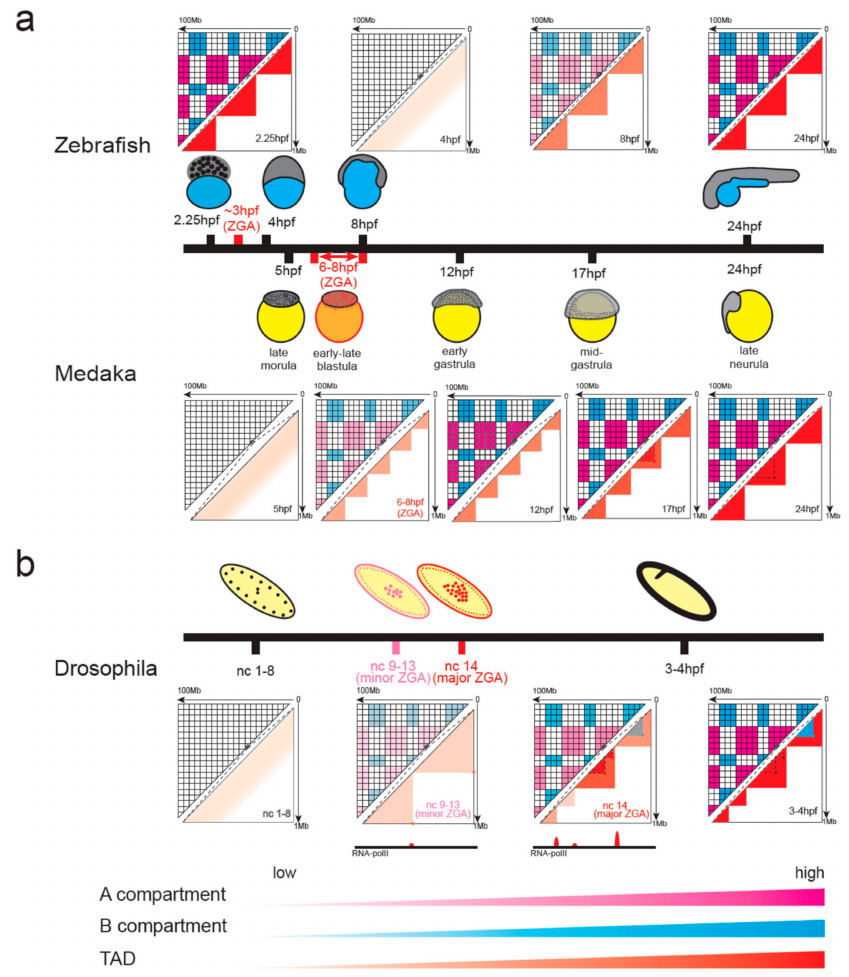
Figure 3. Chromatin remodeling in early embryonic development of zebrafish, medaka ( a ), and Drosophila ( b ). The period of zygote genome activation was colored in red. ( a ) Zebrafish chromatin displayed a unique pattern of systemic loss and regain. In medaka, chromatin structure was established in zygote genome activation (ZGA), but the size of TADs was small. Up to gastrulation, large contact domains matching the size of mature cells will form. ( b ) In Drosophila , chromatin architecture mainly emerges at the onset of ZGA, and TAD boundaries are established concomitant with the binding of RNA Pol II. Polycomb-dependent repressive loops (blue color) are only formed after midblastula